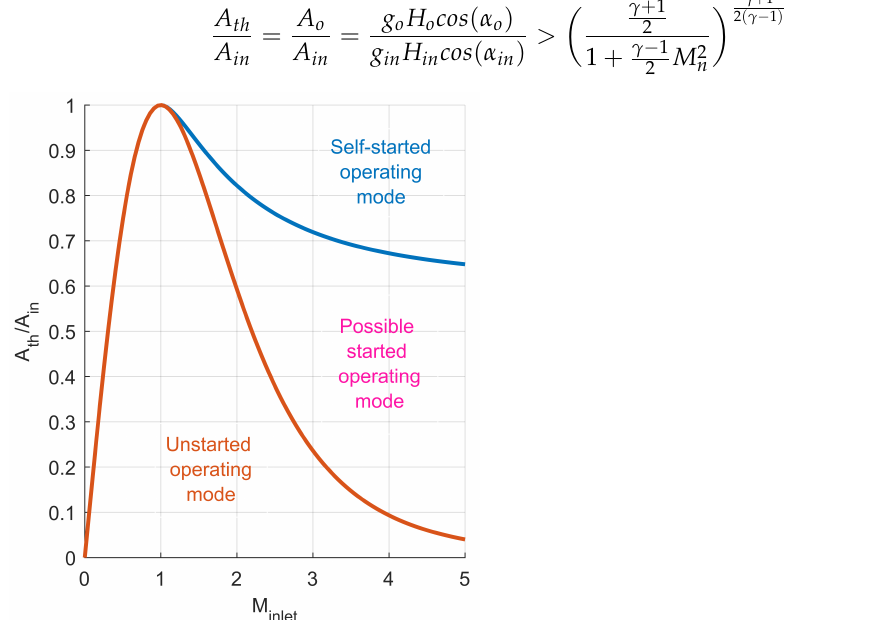
Figure 2. Contraction ratio for a started or unstarted blade row at varying inlet Mach